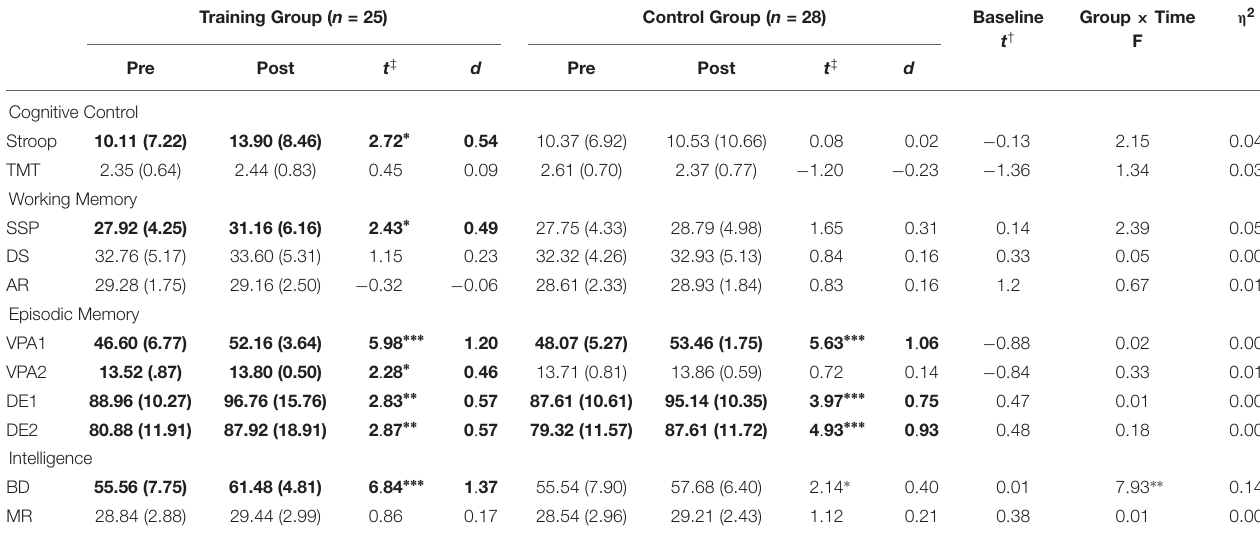
TABLE 2 | Pre- and post-scores and performance changes in the cognitive tests. Training Group ( n = 25) Control Group ( n = 28) Baseline